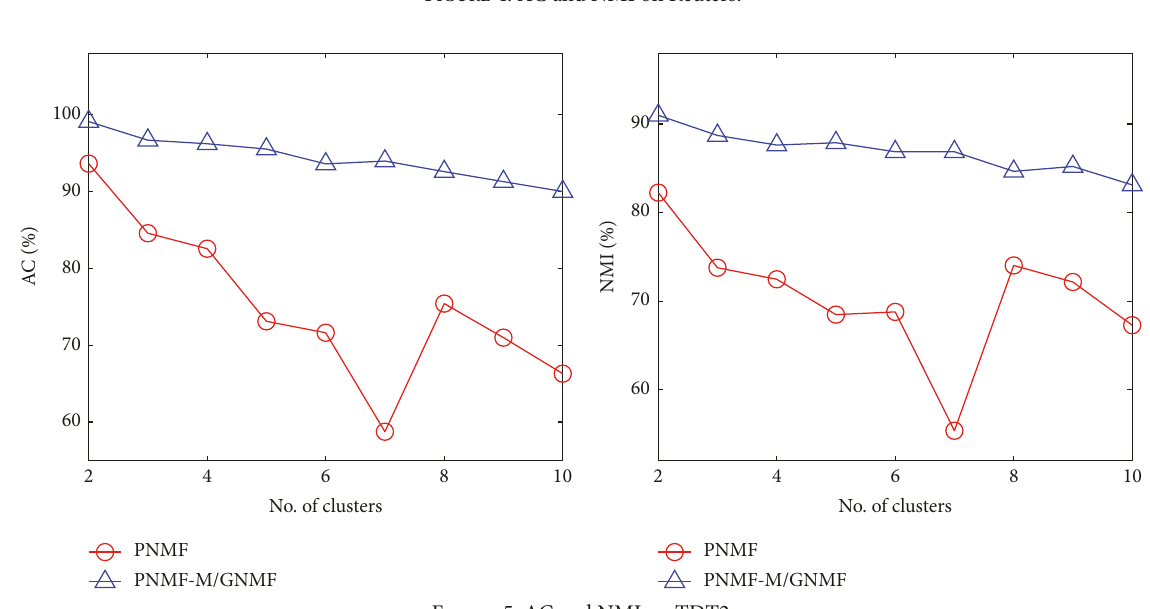
Figure 5: AC and NMI on